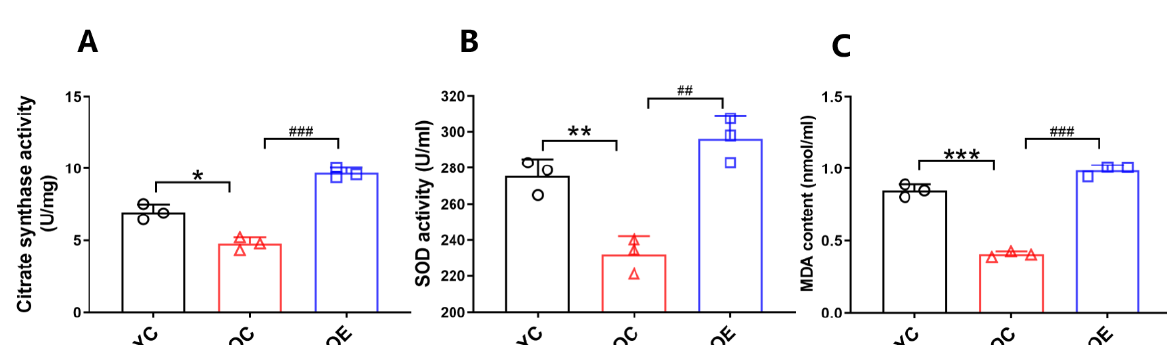
Figure 3. Lifelong aerobic exercise stimulated the increase of CS activity ( A ) in the skeletal muscle, and the increase of SOD activity ( B ) in serum, as well as the reduction of MDA level ( C ) in skeletal muscle. All data are presented as mean ± standard deviation (M ± SD) ( n = 3 mice per group). Group symbols: YC, black circle; OC, red triangle; OE, blue square. *** p < 0.001, ** p < 0.01 and * p < 0.05 vs. YC group; ### p < 0.001, ## p < 0.01 vs. OC group.